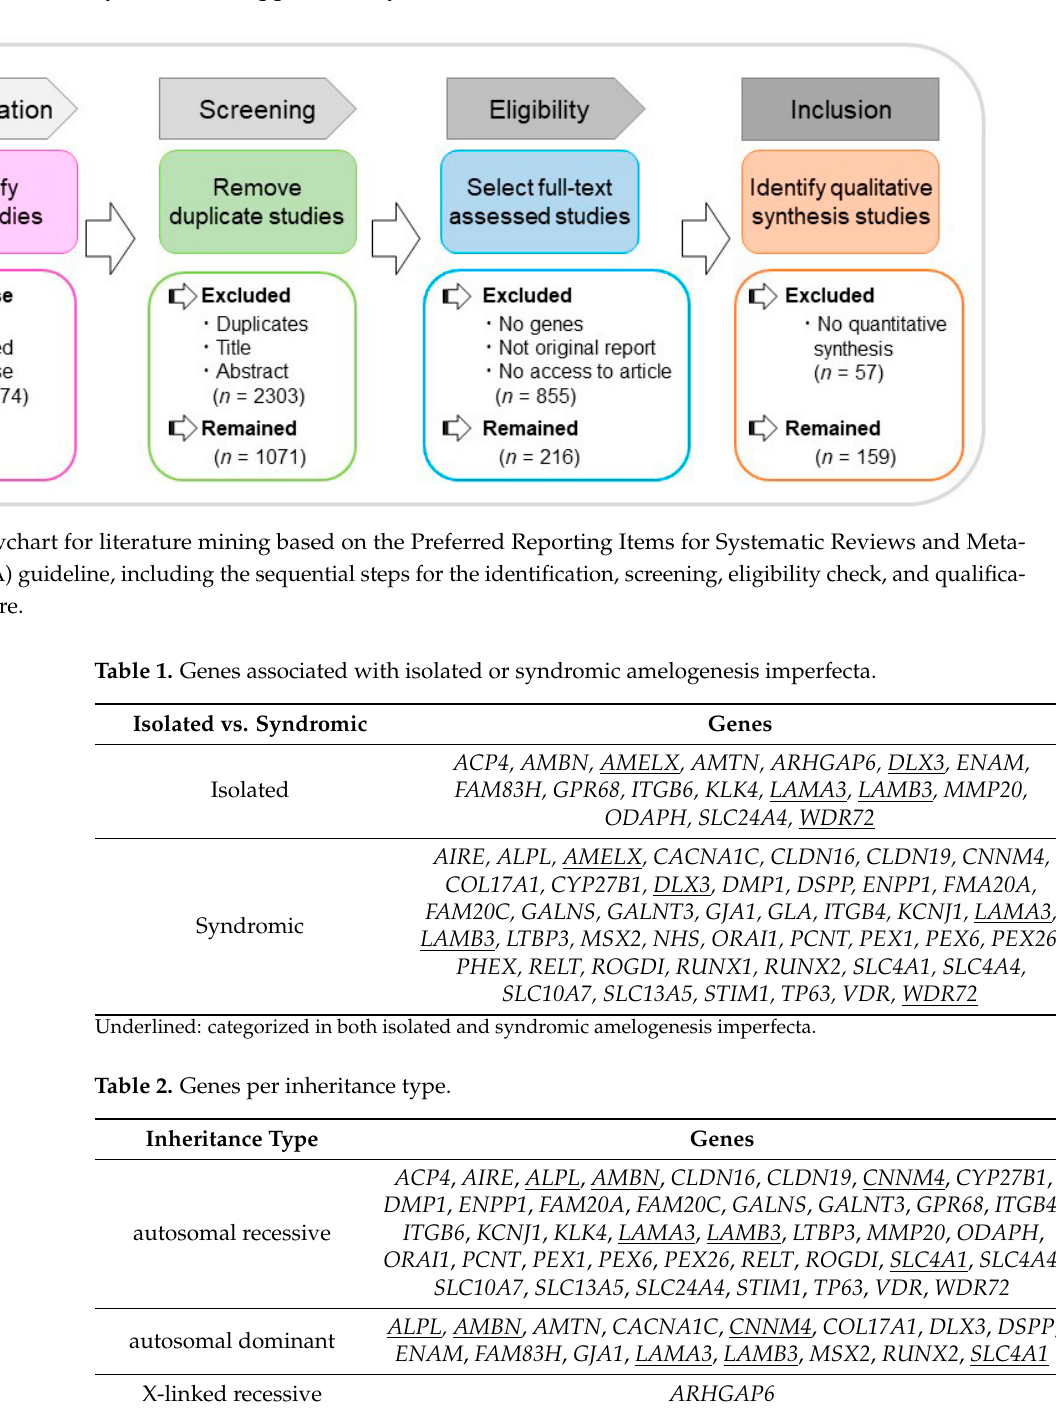
Table 1. Genes associated with isolated or syndromic amelogenesis imperfecta.